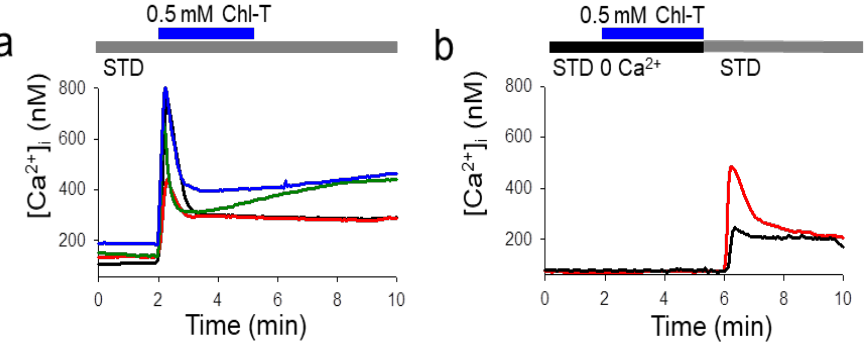
Figure 5. Application of Chl-T increases intracellular Ca 2+ concentration. ( a ) Representative record- ings of [Ca 2+ ] i in different IGR39 cells obtained from different cell preparations after the application of 0.5 mM Chl-T in the standard bath solution containing 2 mM Ca 2+ ( ∆ [Ca 2+ ] i = 640 ± 30 nM (24 cells)). ( b ) Similar experiments obtained in the absence of Ca 2+ in the external solution. Intracellular Ca 2+ increase was observed only when Ca 2+ was added to the bath solution. Horizontal bars indicate the time period of exposure. Note that in zero external calcium the resting cytosolic calcium is lower. Average resting values were 127 ± 9 nM in STD and 75 ± 2 nM without external calcium.